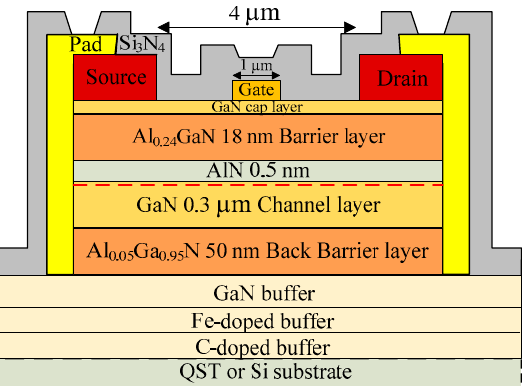
Figure 1. Cross-sections of the GaN on QST, with L G , L DS , and W G being 1, 4, and 50 µm, respectively.